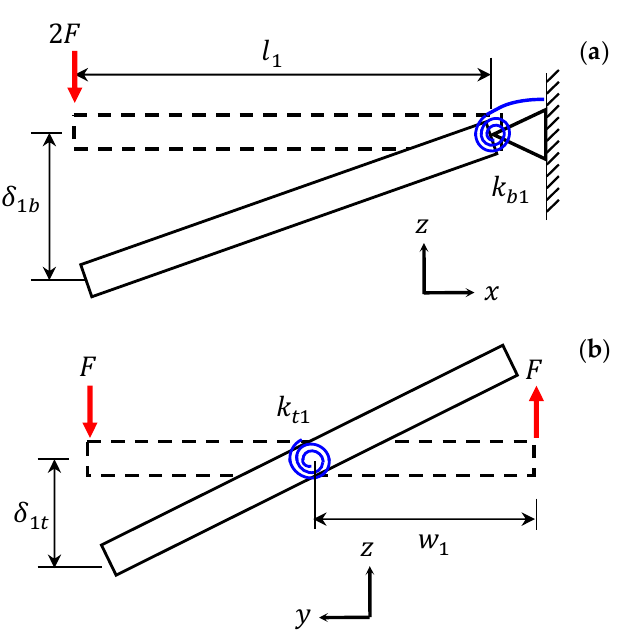
Figure 14. Rigid model of the front body floor to obtain equivalent stiffnesses between the front and middle body floors: ( a ) the bending stiffness and ( b ) the torsional stiffness.